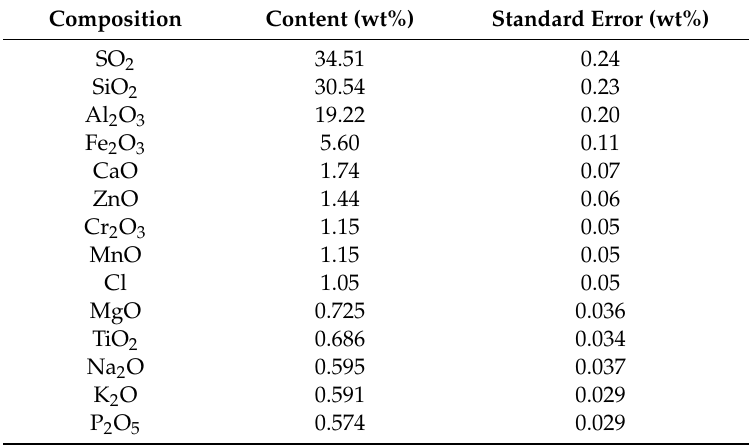
Table 1. XRF data of carbonaceous deposits on the surface of the coking chamber.